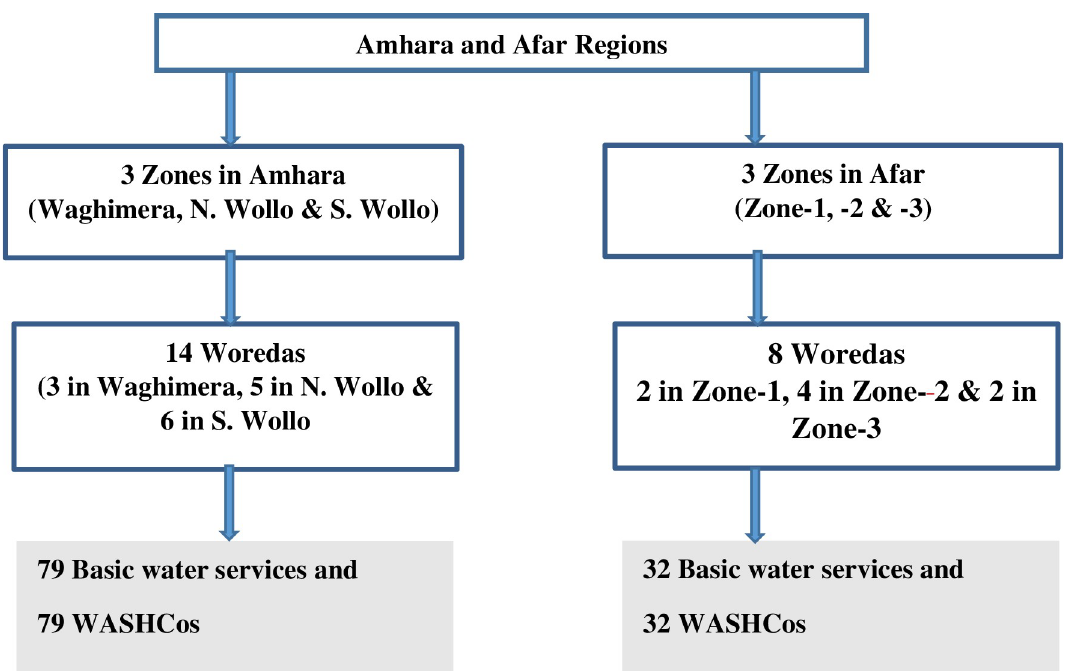
Fig 1. Sampling structure of selected basic water services and associated